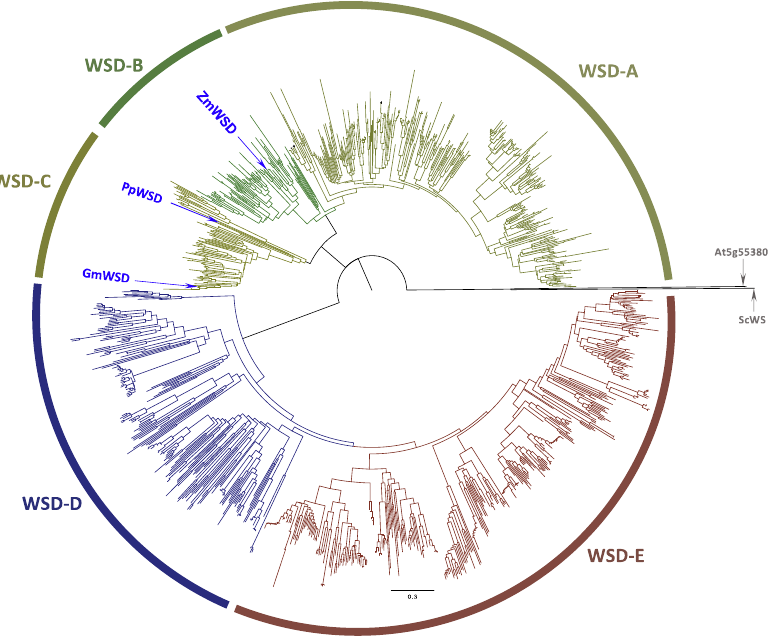
Figure 2. Phylogenetic analysis of bifunctional WSD enzymes. The 1054 sequences used in these analyses are identified in Table S2, and these sequences were identified by sequence homology to the Arabidopsis (AtWSD1) [26] and A. calcoaceticus (AcWSD) [24] sequences using BLASTP. The phylogenetic tree was assembled with neighbor joining method, using the experimentally characterized WS sequences from jojoba WS (ScWS) [22] and the Arabidopsis WS encoded by At5g55380 as the outgroup, and the statistical rigor of the tree was tested with a bootstrap calculation ( n = 1000).